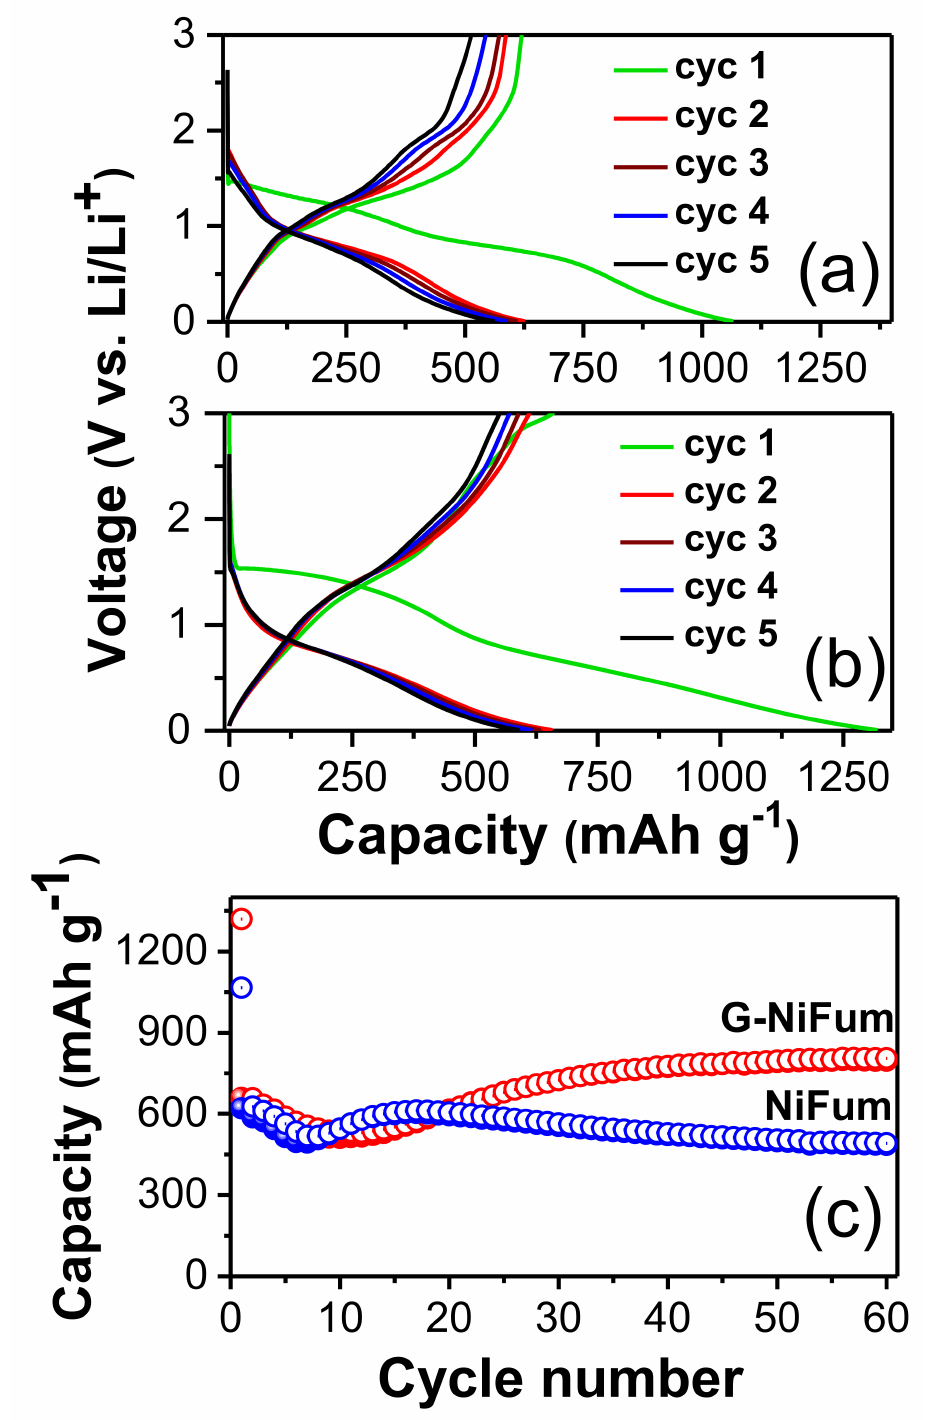
Figure 3. ( a ) Galvanostatic charge–discharge curves of G-NiFum for selected cycles at a current density of 60 mA g − 1 in the potential window of 0.005–3.0 V. The formation step is shown in red; ( b ) comparison of charge–discharge profiles of NiFum and G-NiFum for the third cycle; ( c ) capacity vs. cycle number plots of NiFum and